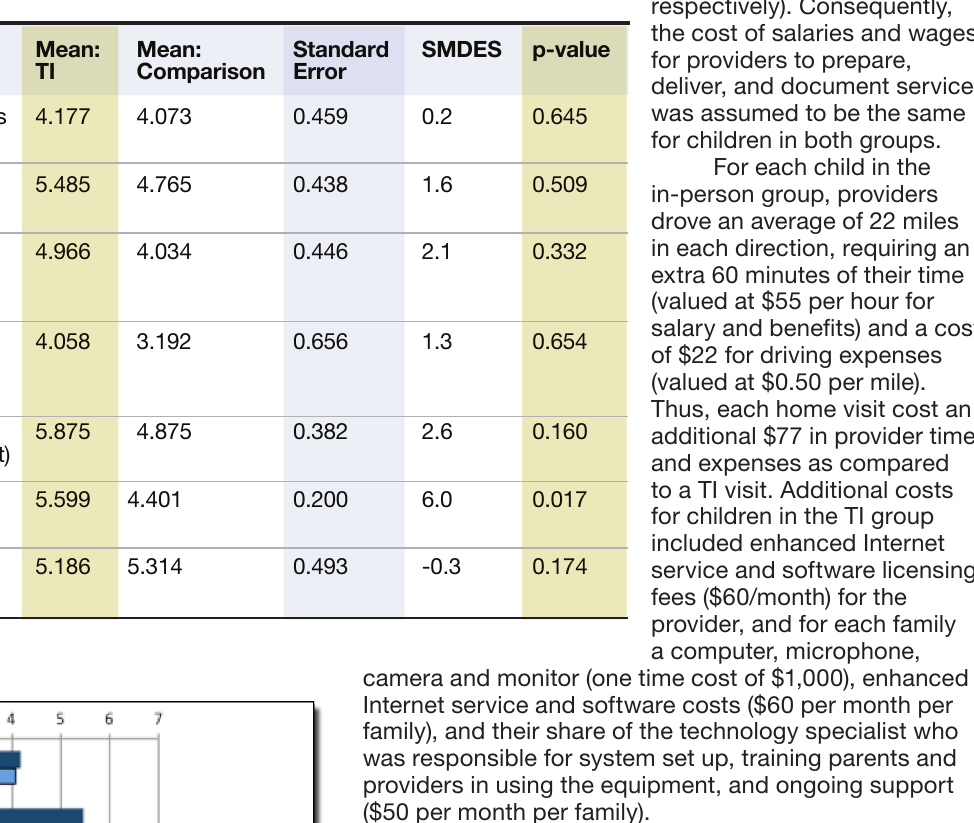
Table 2. Statistics Showing HOVRS Differences between TI and Comparison Groups